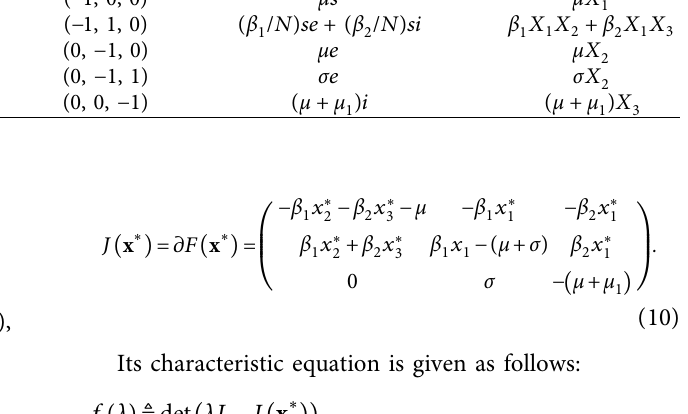
Table 1: State transitions of ( S